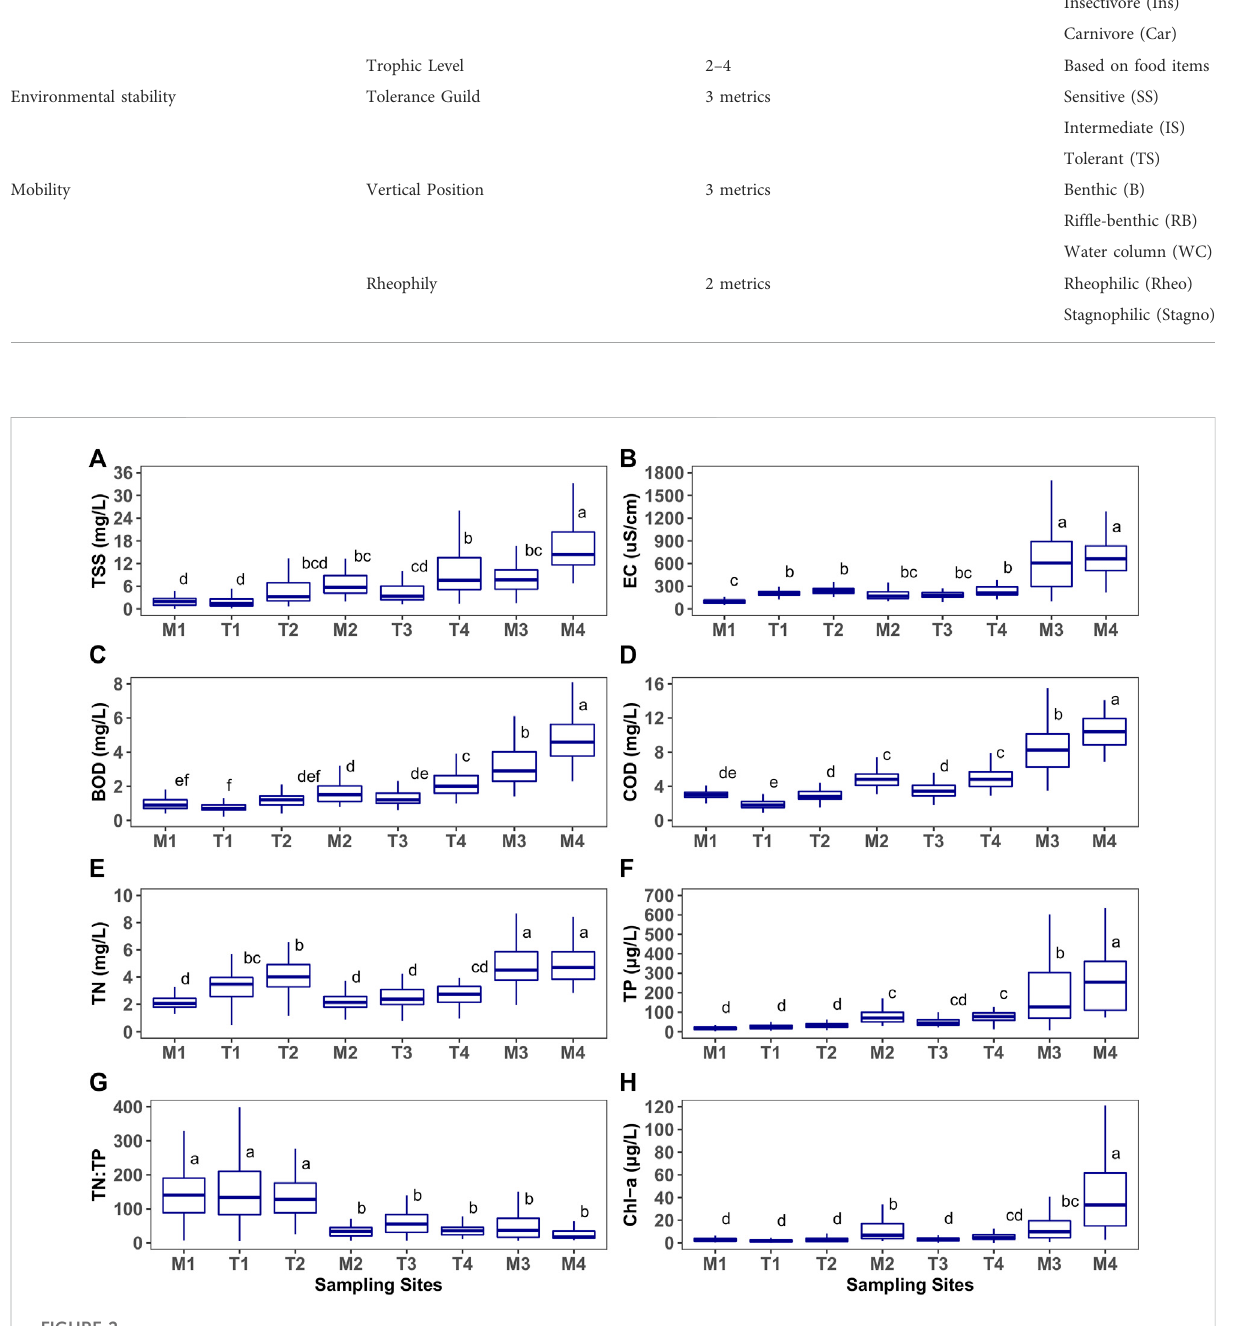
FIGURE 2 Spatial variations of water chemical indicators (TSS, total suspended solids; EC, electrical conductivity; BOD, biological oxygen demand; COD, chemical oxygen demand; TN, total nitrogen; TP, total phosphorus; TN:TP ratio; Chl-a, chlorophyll-a). For each variable, mean values labeled with the same letter do not differ signi fi